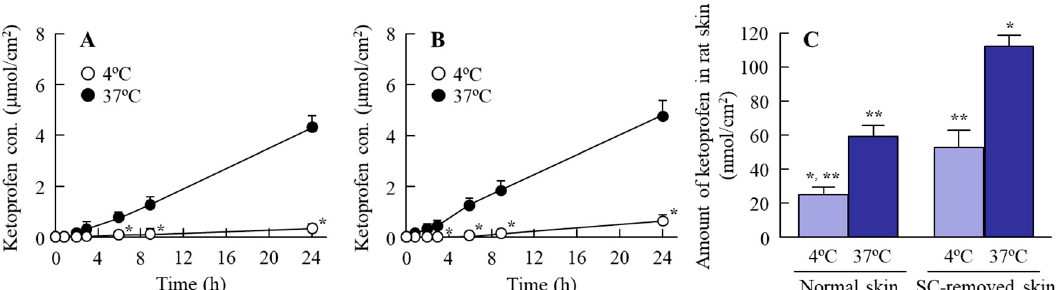
Figure 3. Transdermal penetration of ketoprofen released from the KET-NPs formulation at 4 ◦ C and 37 ◦ C. ( A ) Penetration of the KET-NPs formulation through skin containing SC (normal skin); ( B ) Penetration of the KET-NPs formulation through skin from which the SC was removed (SC-removed skin); ( C ) Amount of ketoprofen in rat skin 24 h after treatment the KET-NPs formulation at 4 ◦ C and 37 ◦ C. The SC was removed by tape stripping. The KET-NPs formulation was applied to skin with (normal skin) or without SC (SC-removed skin). Mean ± S.E. n = 6. * p < 0.05 vs. normal skin at 37 ◦ C for each category. ** p < 0.05 vs. SC-removed skin at 37 ◦ C for each category. The transdermal penetration and amount of ketoprofen in the SC-removed skin was higher than in normal skin. In addition, the transdermal penetration and accumulation of the drug into skin was prevented under the 4 ◦ C conditions in both normal and SC-removed skin. Table 1. Pharmacokinetic analysis of KET-NPs formulation in rat skin at 4 ◦ C and 37 ◦ C. Normal Skin SC-Removed Skin Parameter